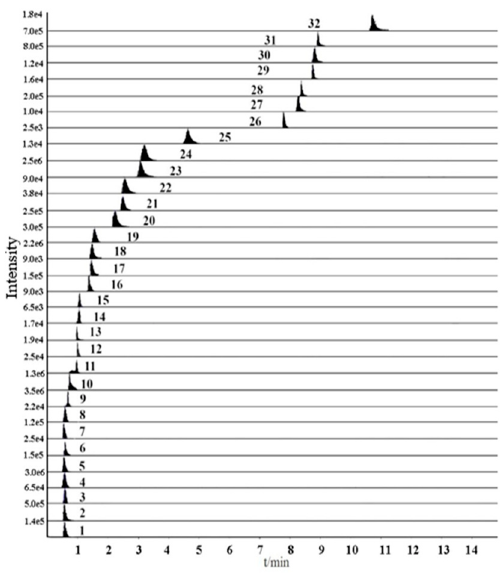
Figure 1. Representative extract ions chromatograms (XIC) of multi-reaction monitoring (MRM) chromatograms of 32 investigated compounds. (Compounds were shown in Table 1).